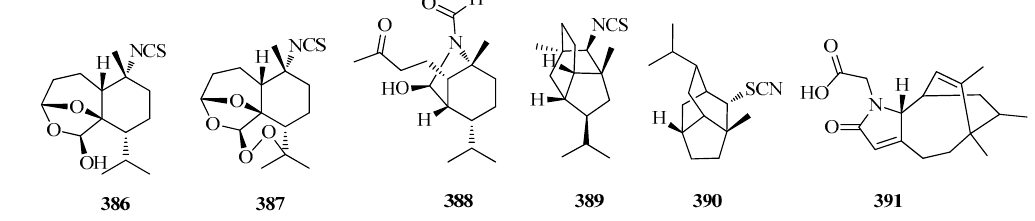
Figure 12. The structures of compounds 386 – 391.